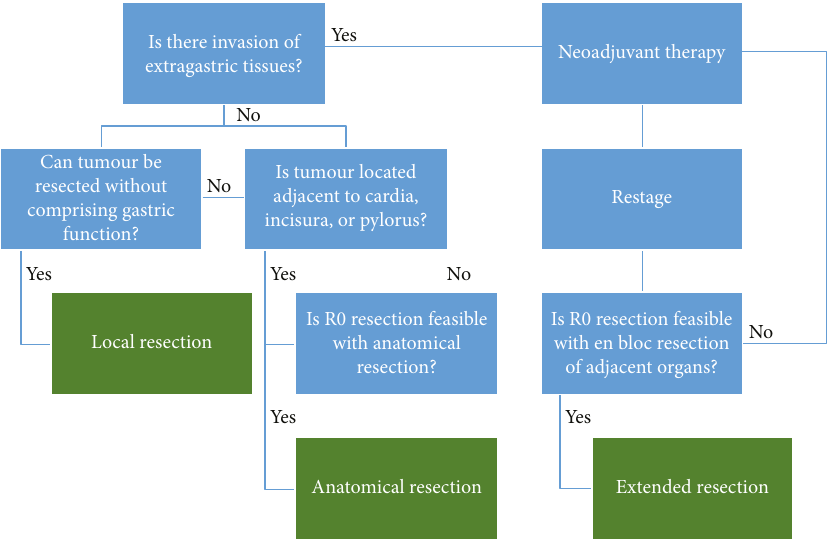
Figure 4: Algorithm for surgical decision-making for gastric